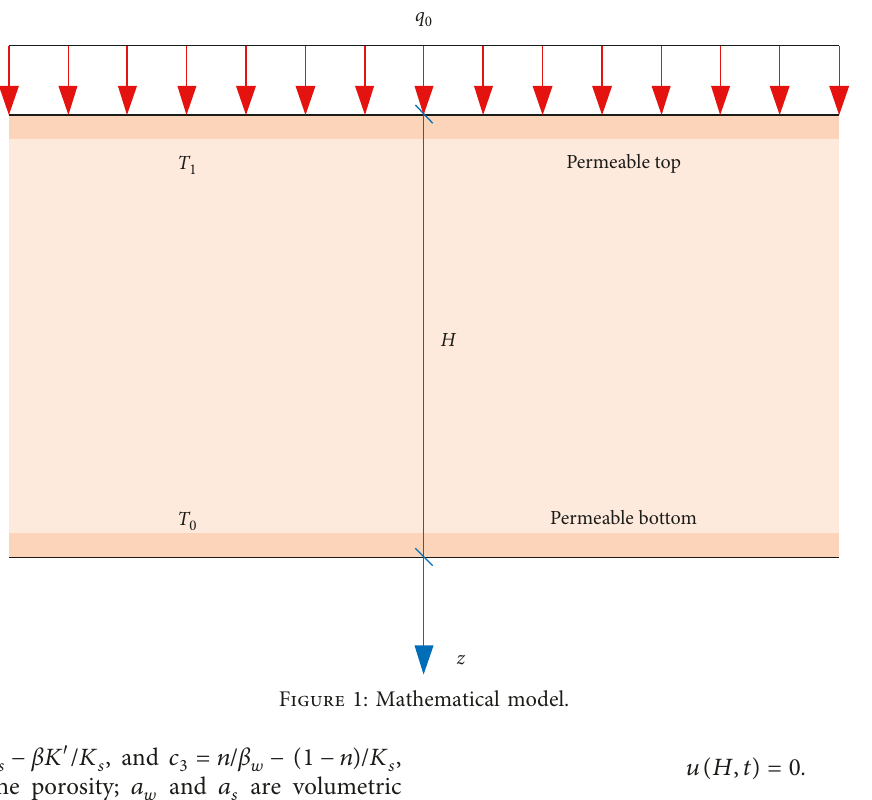
Figure 1: Mathematical